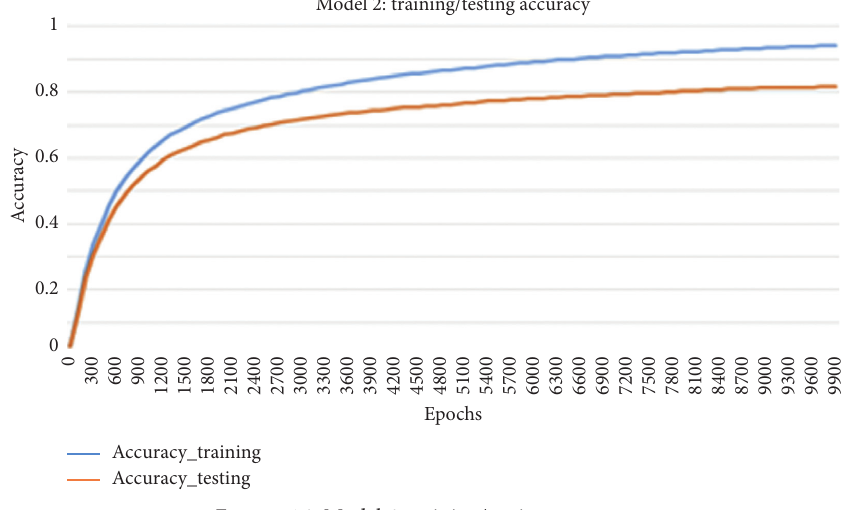
Figure 16: Model 2 training/testing accuracy.